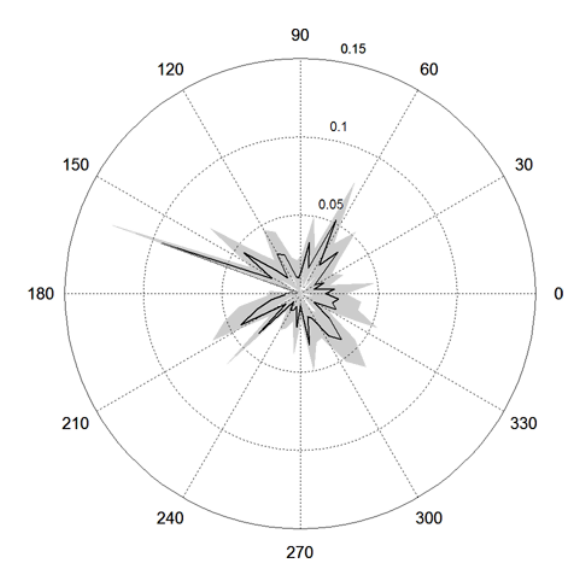
Figure 6. Polar plot of normalized microsaccade trajectories occurring from 3096 to 3118 ms in the condition with no secondary task. Black traces represent the microsaccade rate at particular trajectories during that time interval. The shaded region represents one standard